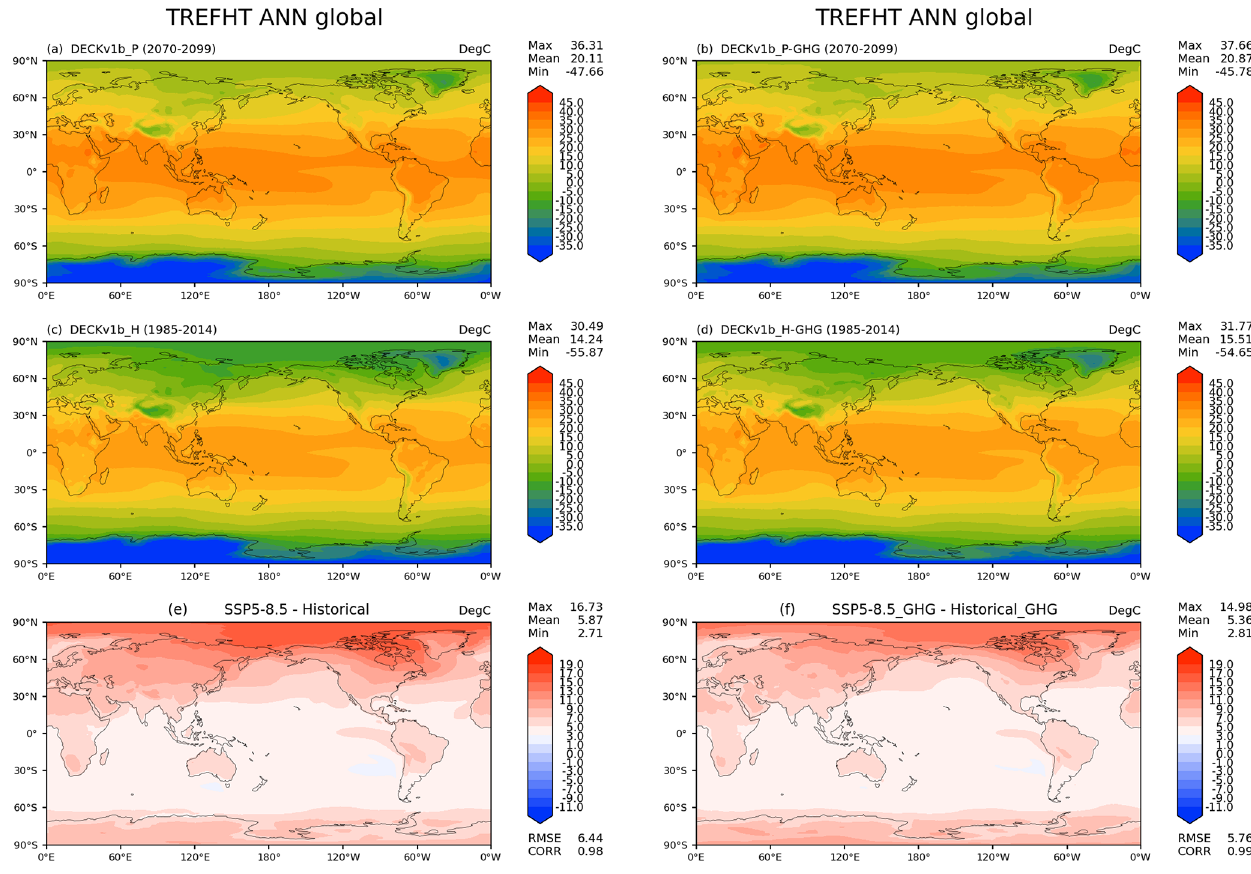
Figure 2. Annual mean T air ( ◦ C) from (a) five SSP5.85 ensemble simulations (2070-2099), (c) five historical ensemble simulations (1985– 2014), and (e) the change between the time period of 2070–2099 and the period of 1985–2014. Annual mean T air ( ◦ C) from (b) three SSP5.85-GHG ensemble simulations (2070–2099), (d) three historical-GHG ensemble simulations (1985–2014), and (f) the change between the time period of 2070–2099 and the period of